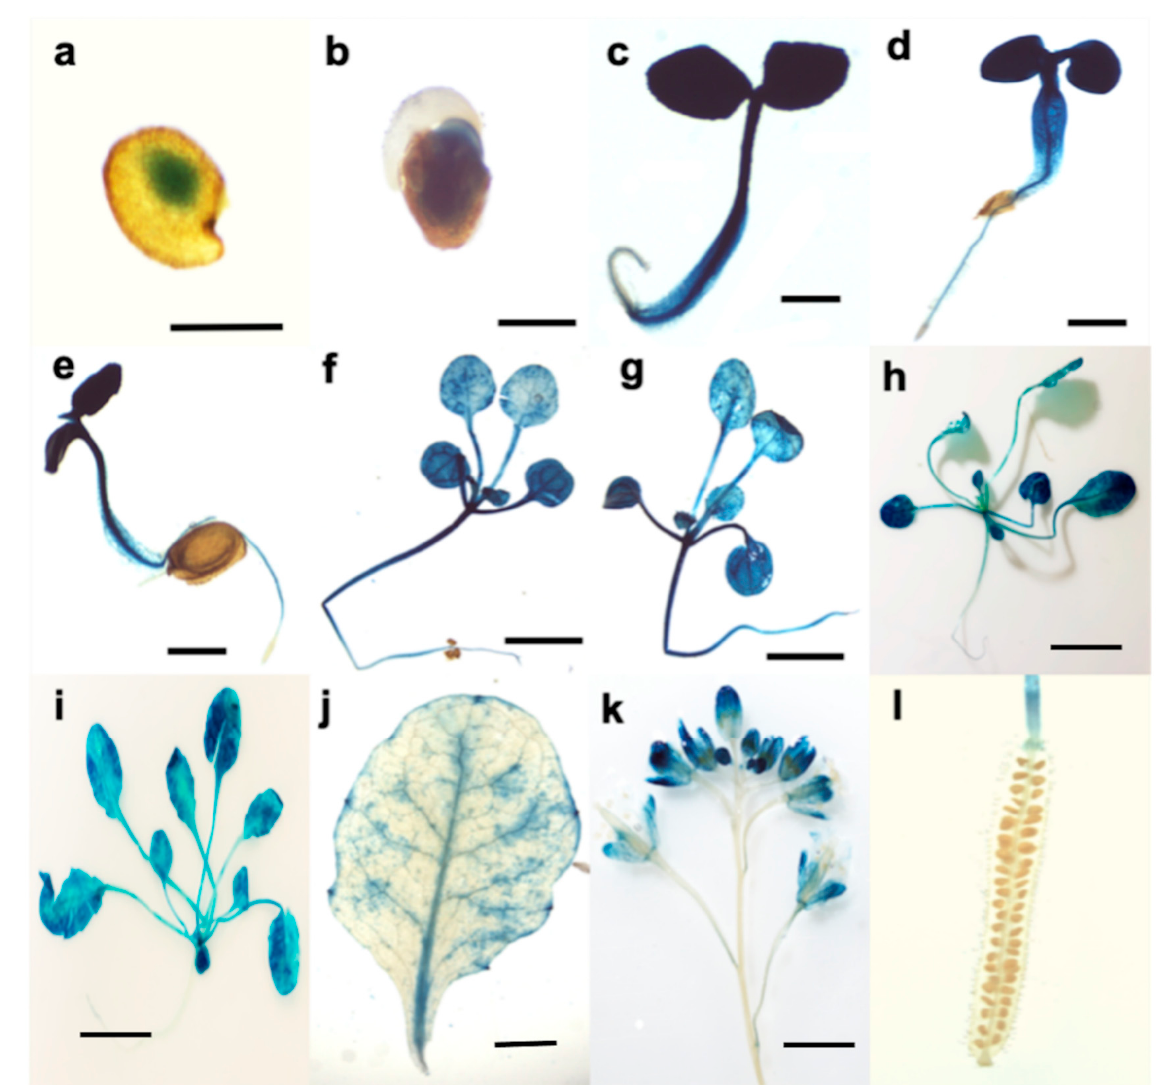
Figure 2. Tissue expression pattern of ATL12 . Histochemical analysis of ATL12 native promoter activity in different Arabidopsis tissues. p ATL12 -GUS activity was detected in 1-day-old germinating seeds, ( a ) 2-day-old seedlings ( b ), 3-day-old seedlings ( c ), 4-day-old seedlings ( d ), 5-day-old seedlings ( e ), 6-day-old seedlings ( f ), one week-old seedlings ( g ), two-week-old seedlings ( h ), three-week-old seedlings ( i ), four-week-old leaf ( j ), Flowers ( k ), and siliques ( l ). Scale bar represents 1 mm.